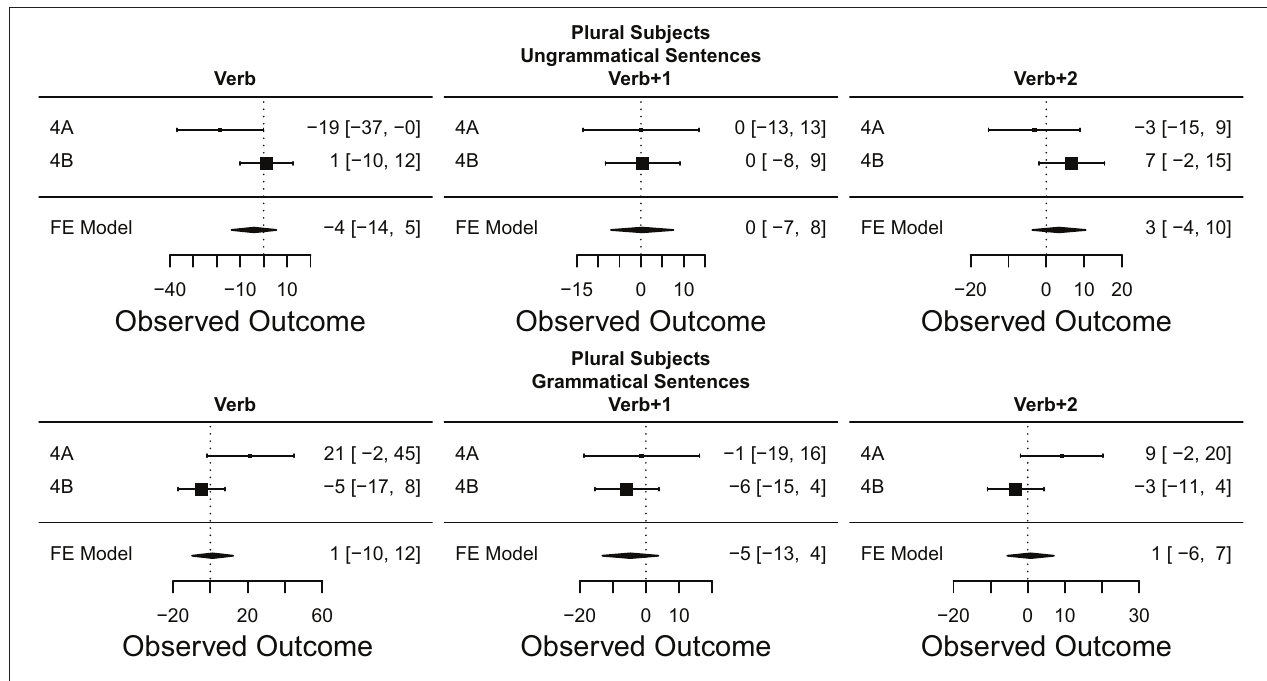
Figure 9 | Number effect in ungrammatical and grammatical sentences: forest plots of meta-analysis for plural subjects. The size of the square representing each experiment is proportional to its weight in the meta-analysis. The estimated effect size of the meta-analysis is represented by the black diamond at the bottom of each graph. The width of the diamond represents the estimated 95% CI of the meta-analysis effect size. Experiments are plotted in chronological order from top to